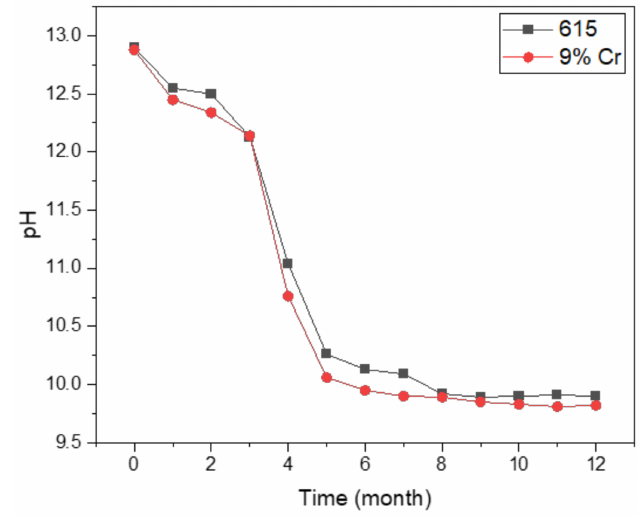
Figure 3. pH values of the solution during the immersion